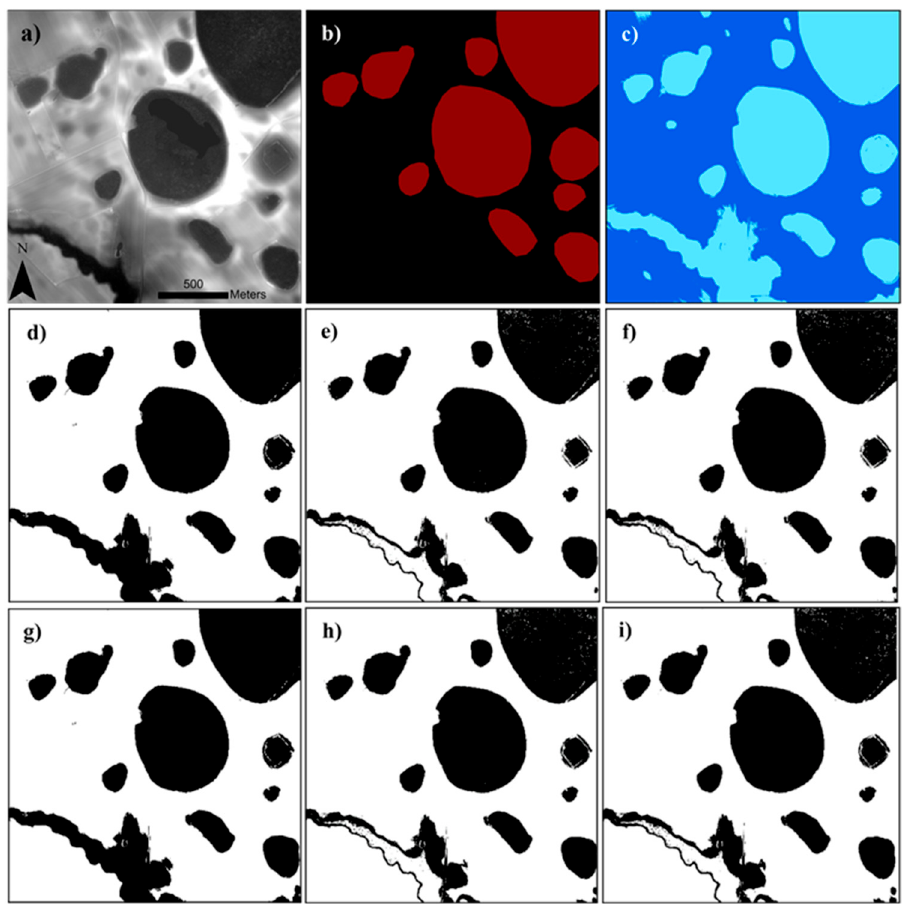
Figure 4 . ( a ) Input DEM. ( b ) Mask annotation. ( c ) K-means unsupervised two-class classifier. ( d ) GaussianNB supervised classifier. ( e ) Decision Tree supervised classifier. ( f ) Random Forest supervised classifier. ( g ) Quadratic Discriminant supervised classifier. ( h ) MLP supervised classifier. ( i ) AdaBoost supervised classifier.